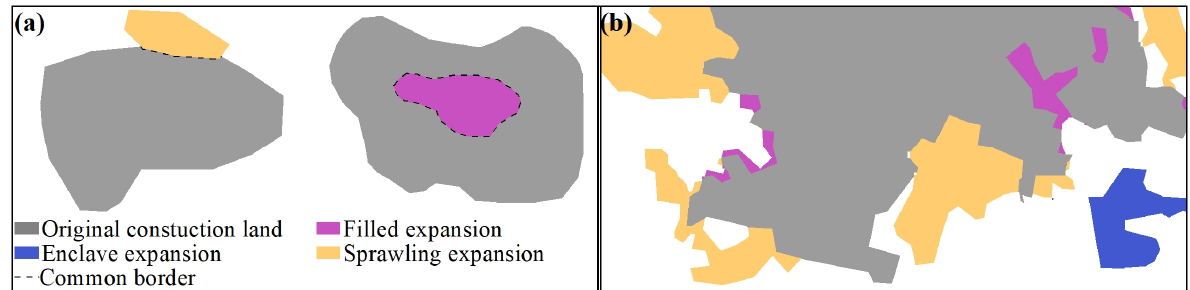
Figure 2. ( a ) Common boundaries for construction land expansion; ( b ) typology of construction land expansion.